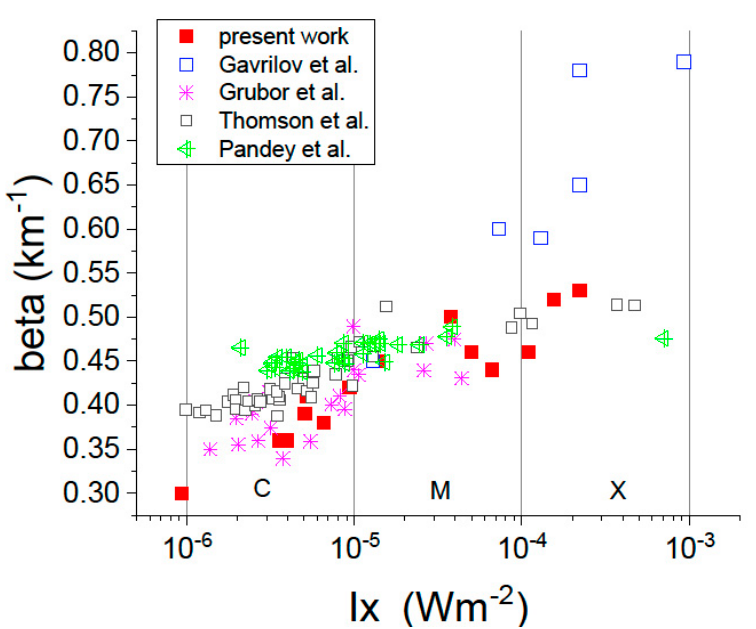
Figure 13. Same as in Figure 12 but for the sharpness parameter.